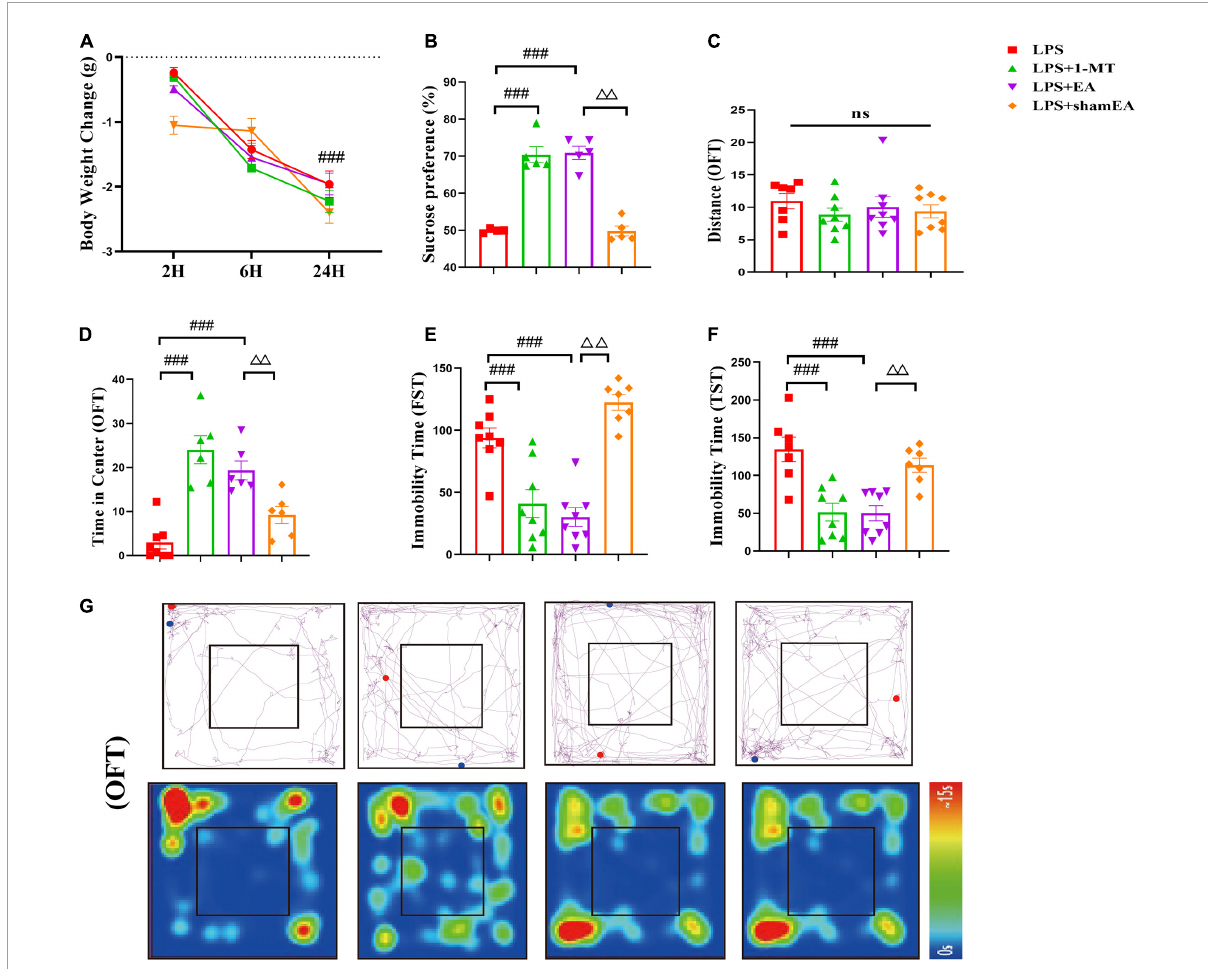
FIGURE6 Electroacupuncture alleviates depression-like behavior induced by LPS in mice. Illness severity indicators were assessed, including (A) weight loss, (B) sucrose preference test, and (C) total distance traveled in the open field test (OFT). Depression-like behavior was evaluated by (D) time spent in the center square and effects of EA on LPS-induced locomotor activity and cognitive functions in mice (G) , immobility time in FST (E) , and immobility time in TST (F) . All data were expressed as the mean ± SEM ( n = 8 per group). ### p < 0.001, compared with the LPS group; (cid:49)(cid:49) p < 0.01, compared with the sham EA group. ns , no statistical